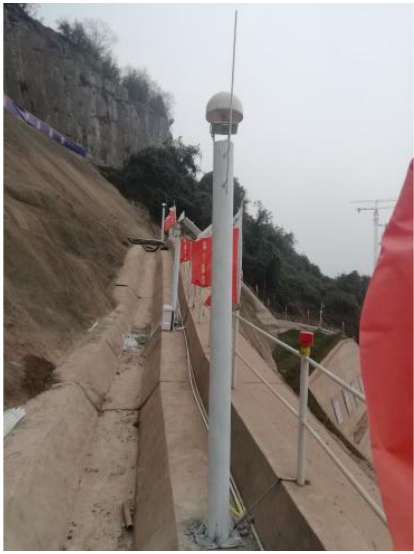
Figure 31. The displacement monitoring device of construction site.